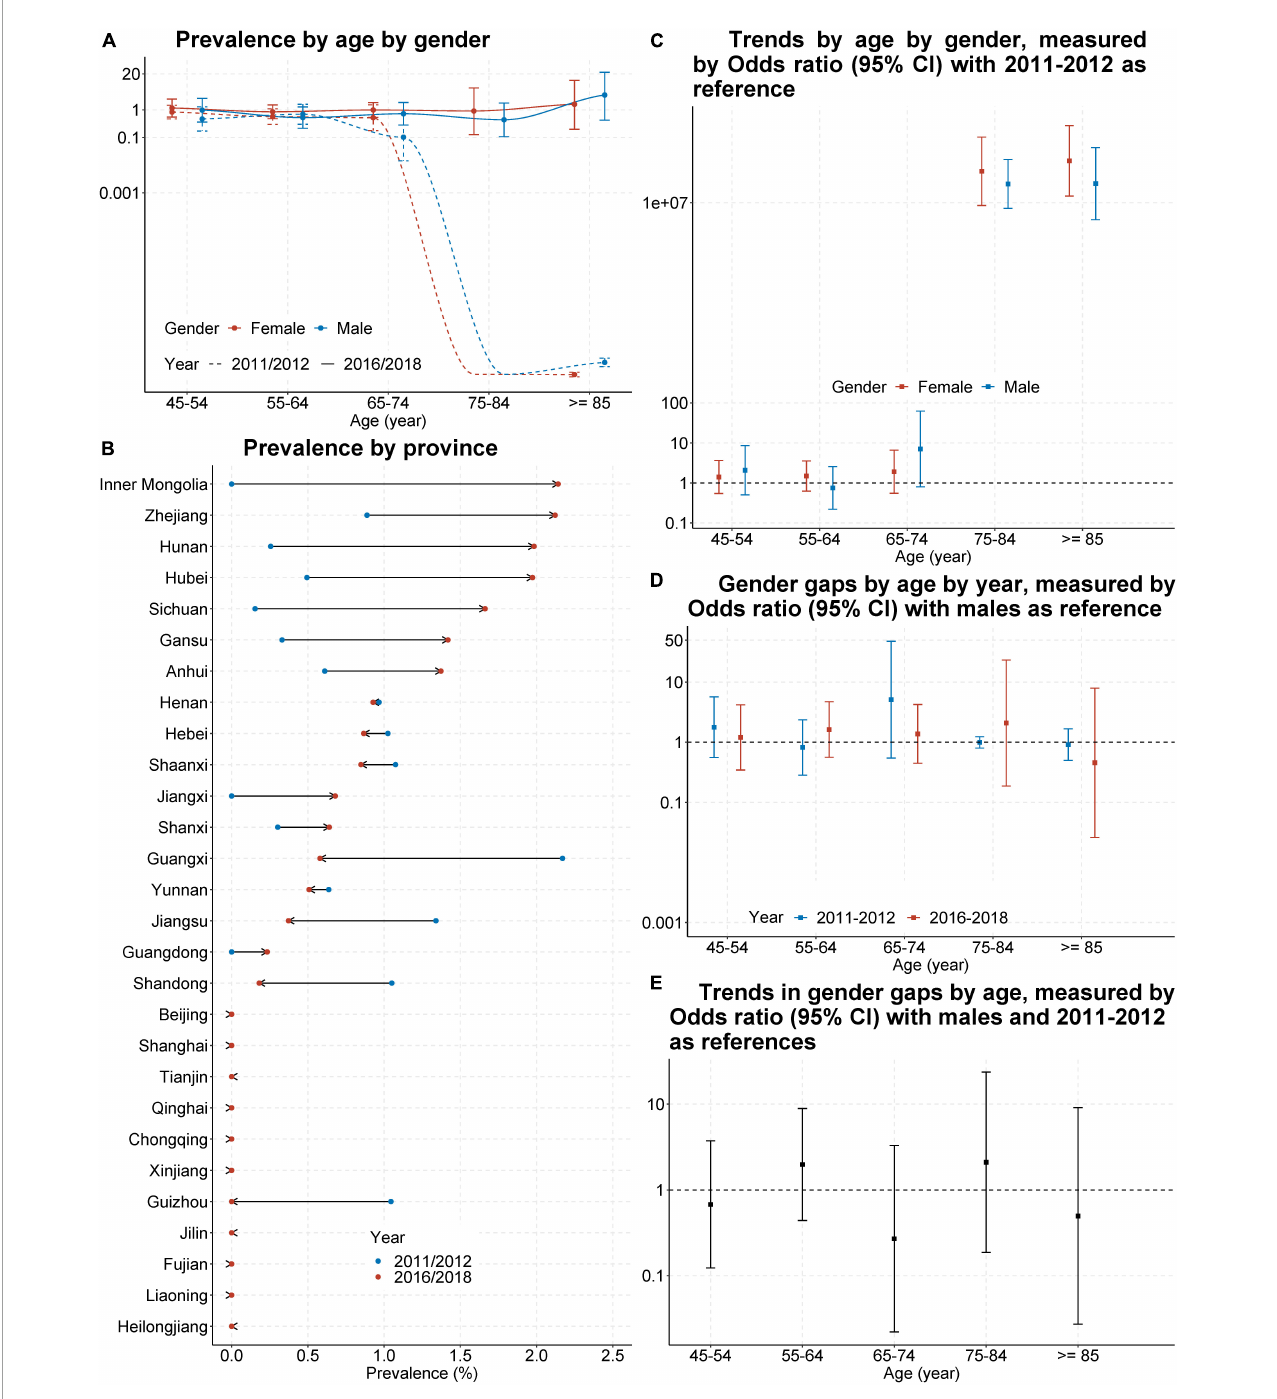
FIGURE2 Prevalence and trend of those who received any needed treatment or counselling from a mental health professional in China, from 2011–2012 to 2016–2018. Shown is the proportion of populations who received any needed treatment or counselling from a mental health professional in China by age and gender (A) or by sampled provinces or cities (B) . Also shown are odds ratio and its 95% confidence interval (CI) for trend of this prevalence by age and gender (C) , gender gap of this prevalence by age and study year (D) , and for the change of gender gap by age (E) . Odds ratio and its 95% CI was estimated from survey-specific weighted regression models and then pooled by meta-analysis. Odds ratio > 1 means the prevalence higher in females (D) or during 2016–2018 (C,E)